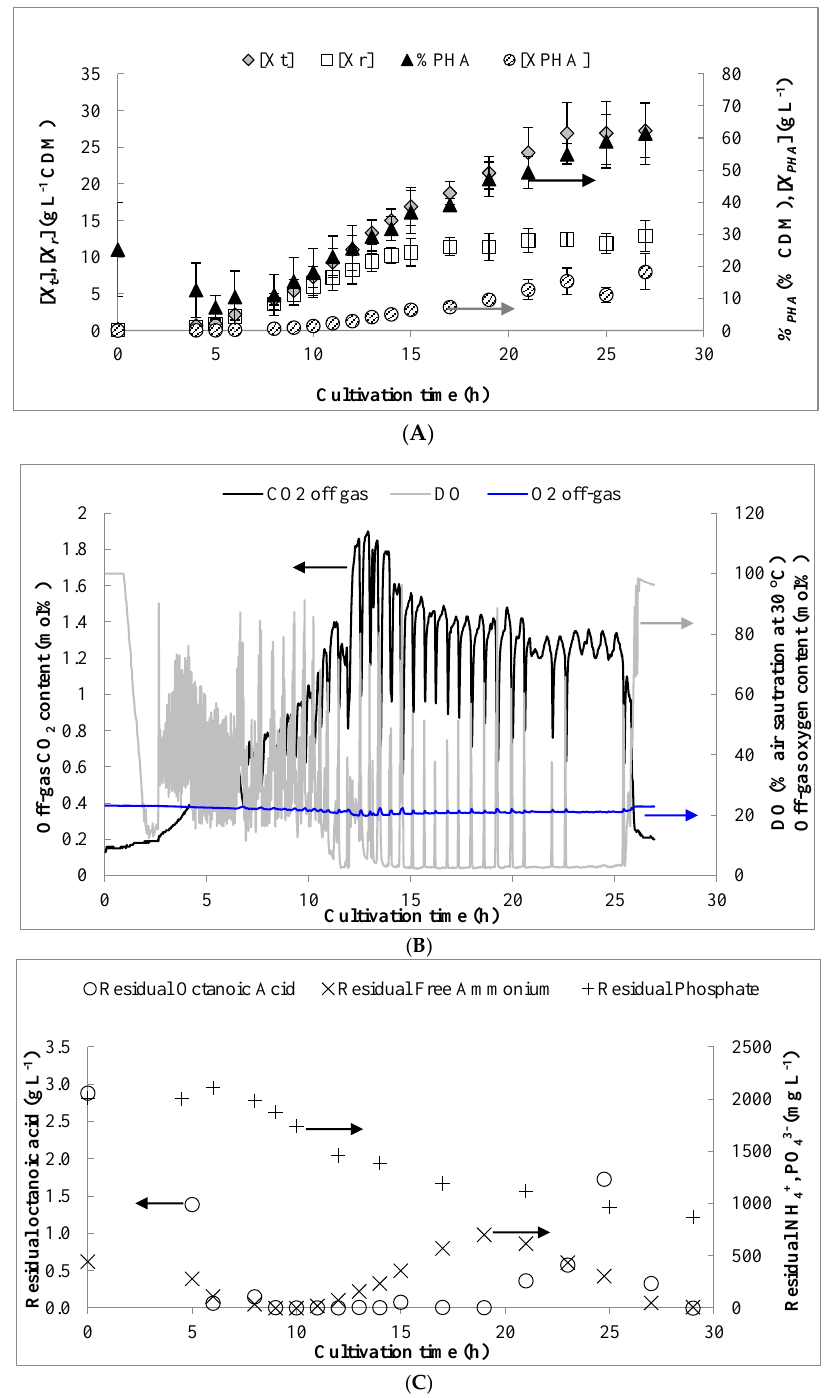
Figure 1. ( A ) Results for biomass and polyhydroxyalkanoate (PHA) production obtained over the course of the pulse feed experiments. ( B ) Representative profile for dissolved oxygen (DO) content over time as well as o ff -gas CO 2 and O 2 content. ( C ) Residual concentrations of octanoic acid, free ammonium, and phosphate observed during the bench scale pulse feed experiments. Results shown are for a representative pulse feed experiment. Error bars represent standard deviations between three biological